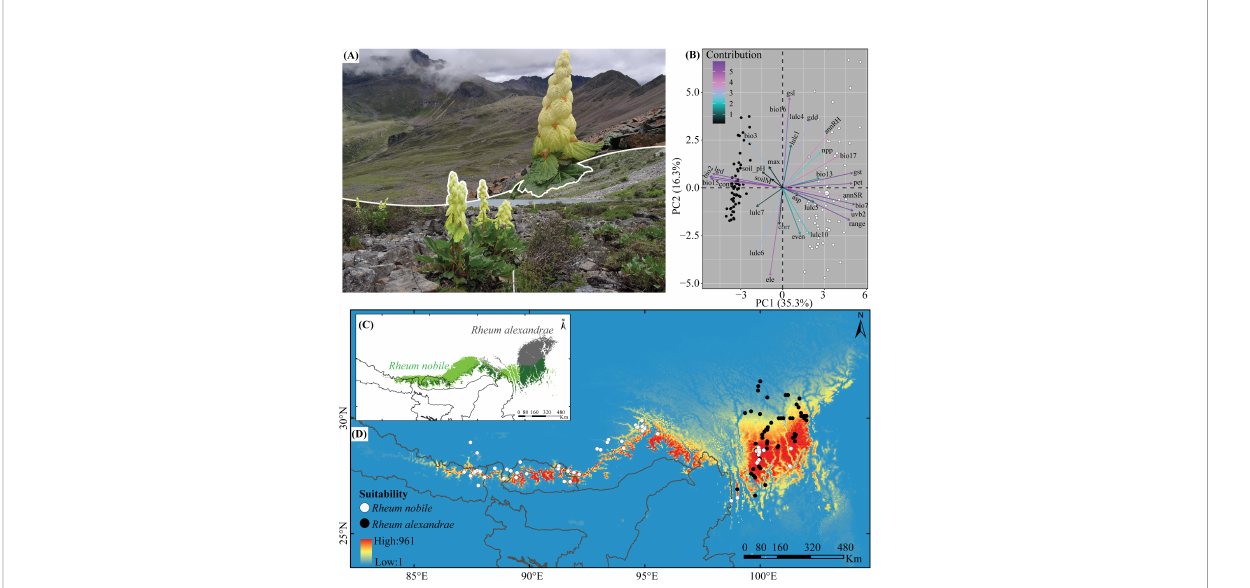
FIGURE 1 (A) Images of Rheum nobile (above) and Rheum alexandrae (below) in their respective habitats. (B) The relative contribution of the predictive environmental variables (colored arrows) to the two axes of biplots from principal components analysis (PCA). The distribution area of both species as a function of (C) raster overlay and (D) fuzzy overlay depicts their present-day bio-climatically suitable niche in the Eastern Himalaya (EH) and the Hengduan Mountains (HM). The two dots in (B, D) represent the occurrence points for R. nobile (white dot) and R. alexandrae (black